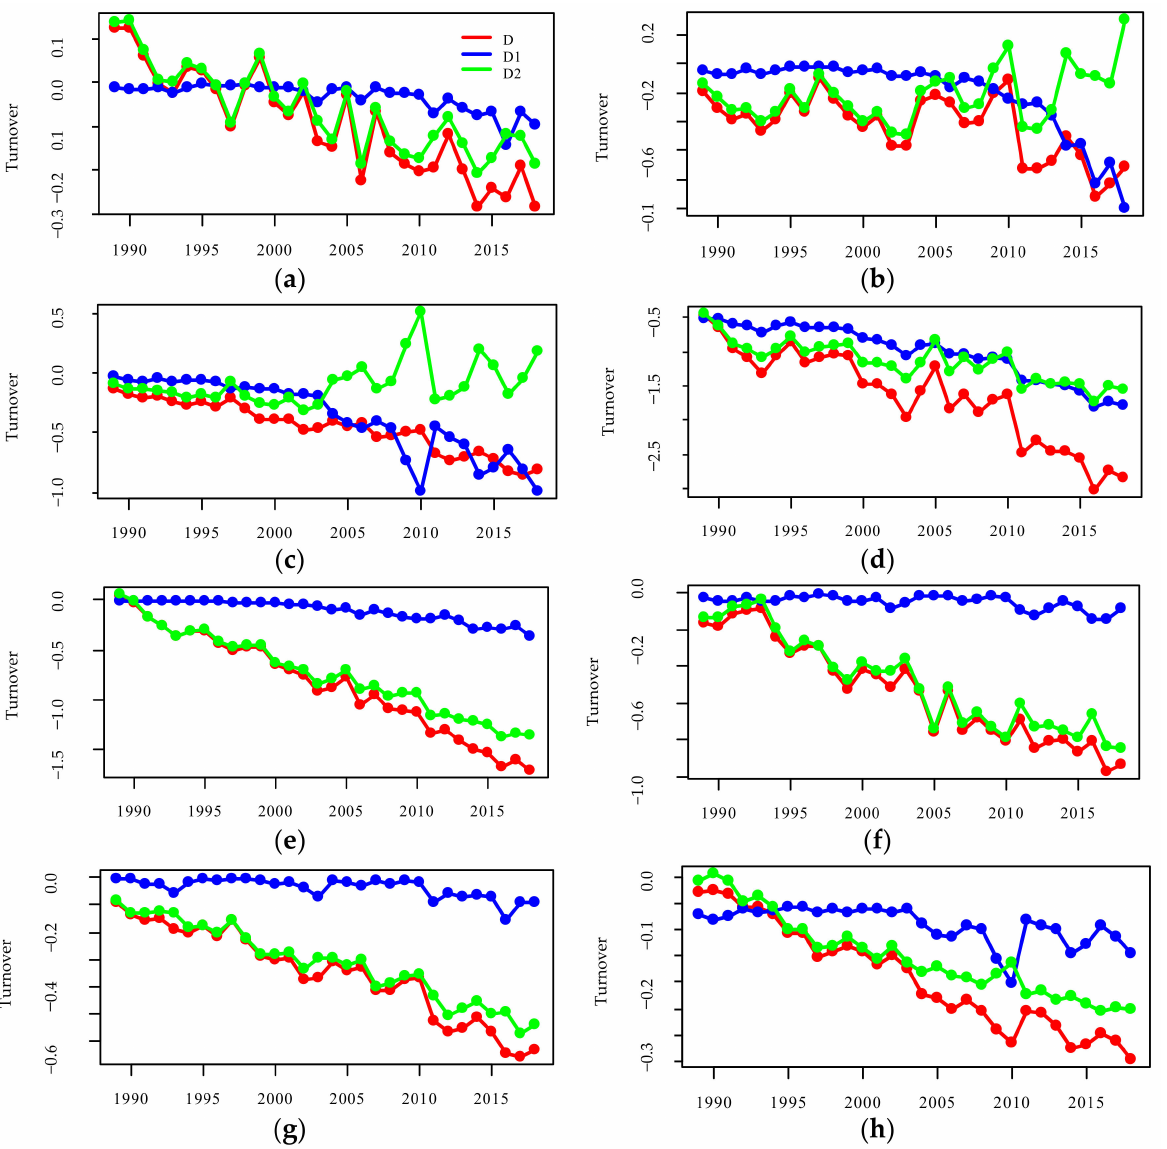
Figure 3. Bird species composition turnover (D: the red line) and its components, composition change (D1: the blue line) and community size (species richness) change (D2: the green line) obtained after the turnover analysis of the bird communities at Molochna River valley over the period (1988–2018): the abscissa is the order of years and the ordinate is the turnover. ( a )—Agricultural lands, ( b )— Forest shelterbelts, ( c )—Meadows, ( d )—Reed beds, ( e )—Rural areas, ( f )—Salt marshes, ( g )—Steppe, ( h )—Forest